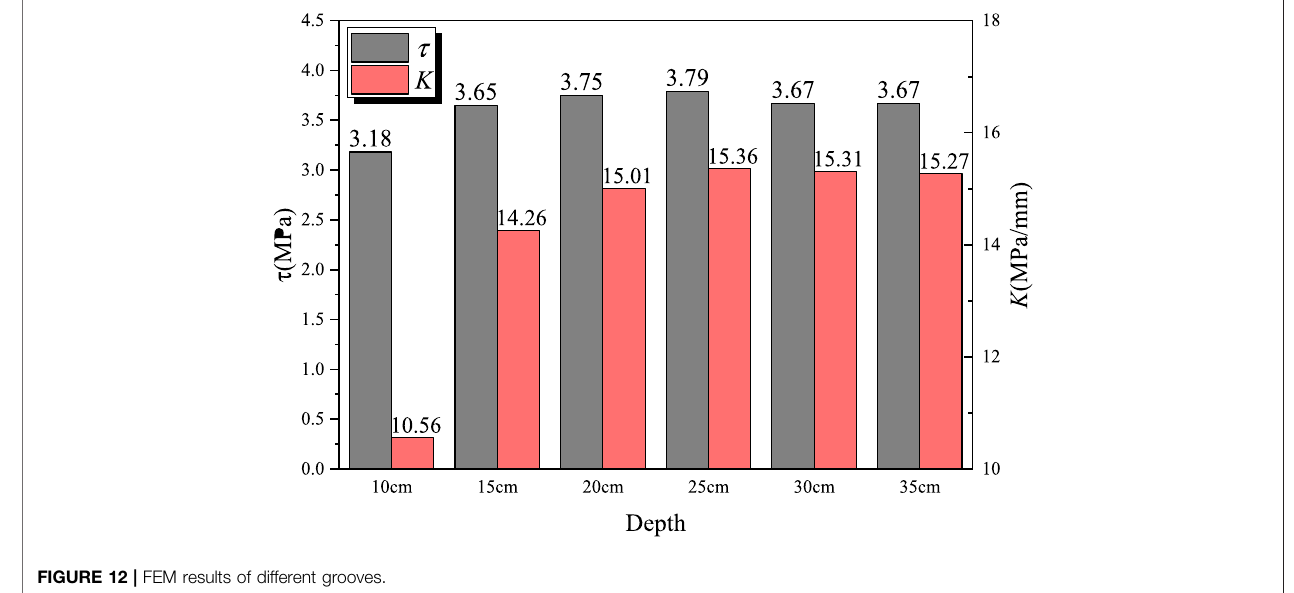
FIGURE 12 | FEM results of different